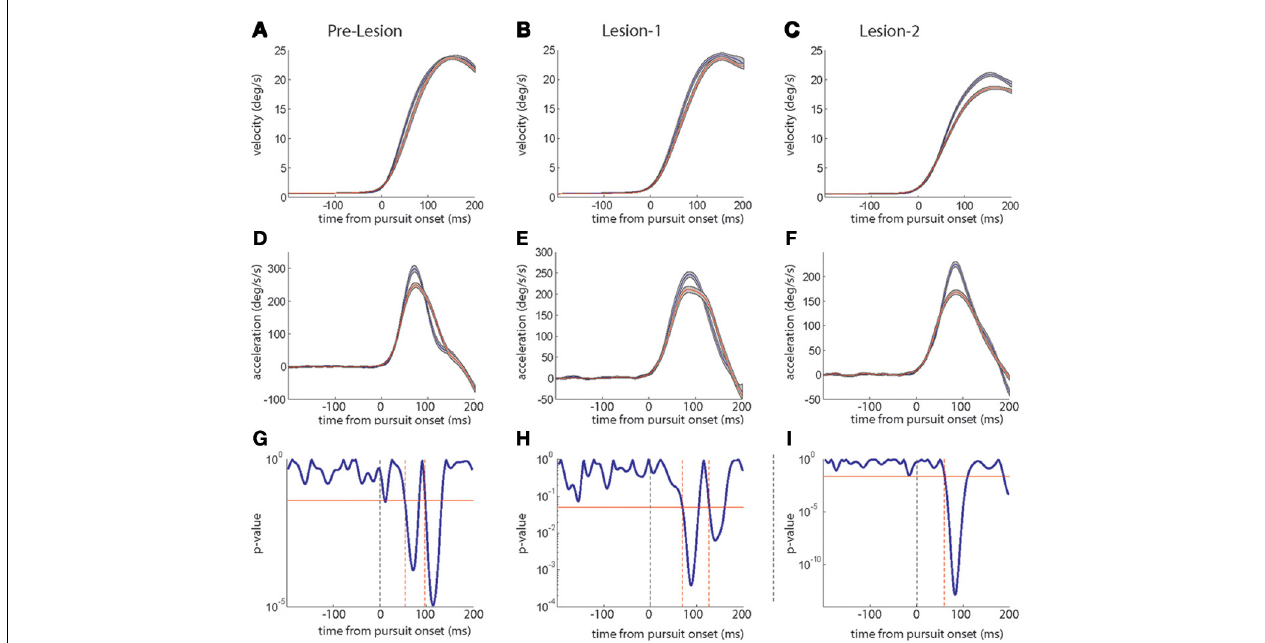
FIGURE 6 | Plots of average instantaneous eye velocity (top row) and eye acceleration (middle row) as function of time in a trial. Blue traces give the averages for the first, red traces the averages for the last quartile of trials. The first column depicts the pre-lesion data, the middle column data collected 20 days after L1 and the right column shows data acquired 45 days after L2. The gray shadow around the red and blue traces signifies